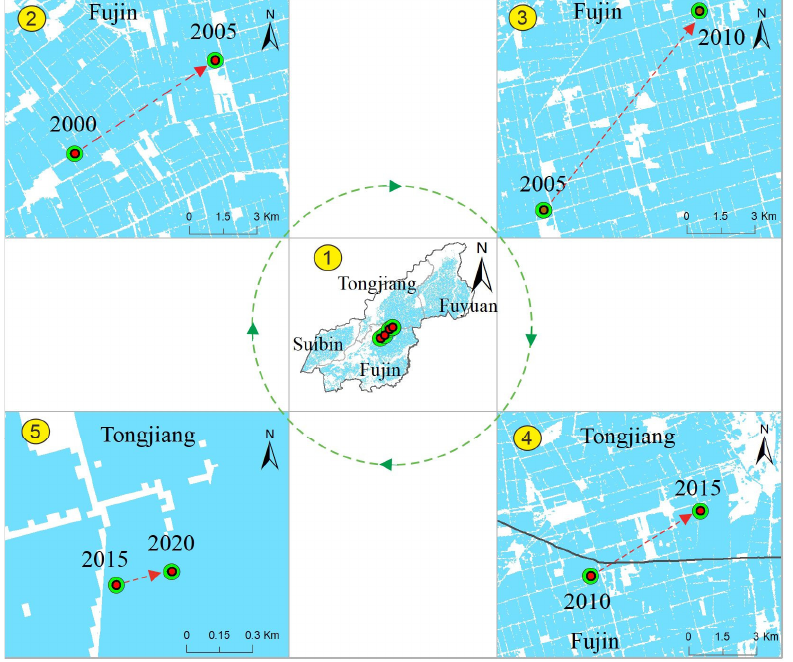
Figure 5. Center of gravity migration trajectory from 2000 to 2020. Note: number 1 was the study area, and number 2 to 5 was the center of gravity transfer with 5-year interval from 2000–2020